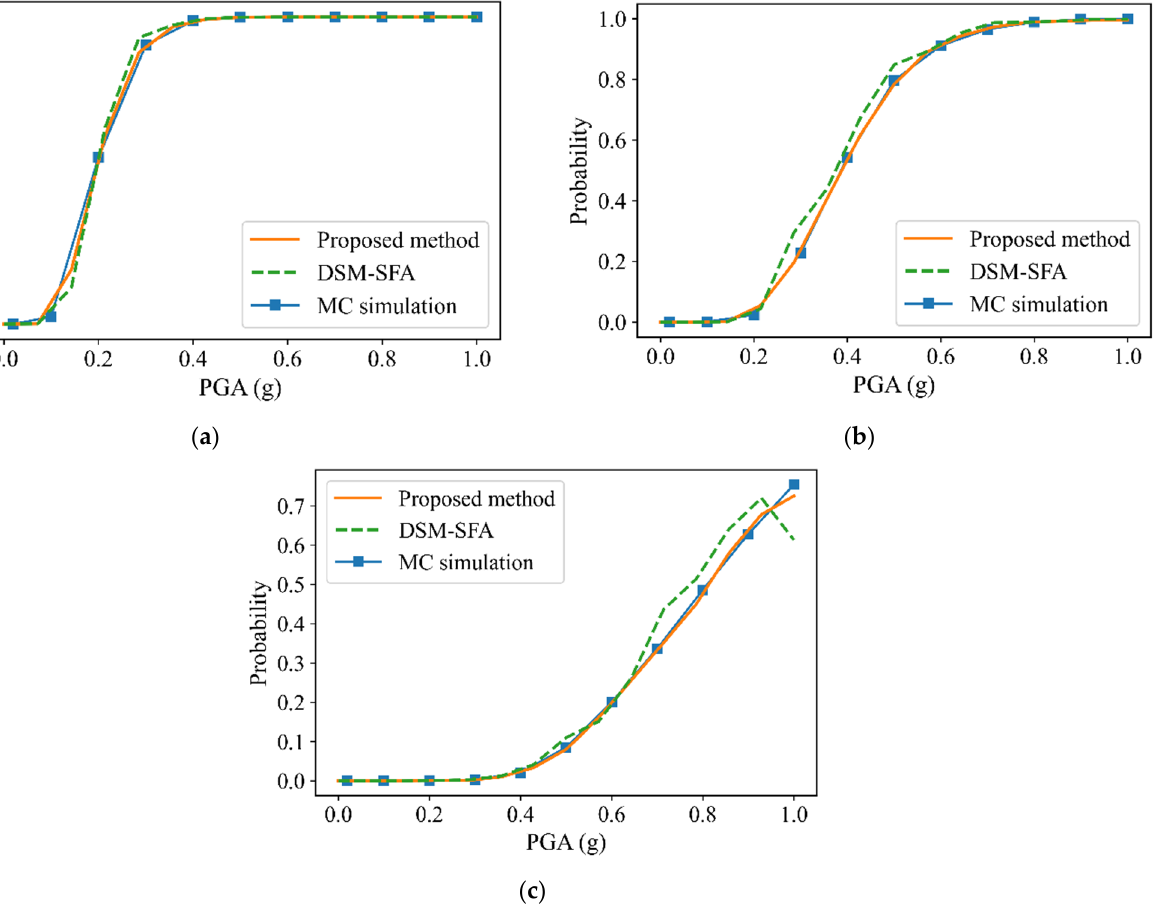
Figure 7. Fragility curves obtained using different approaches. ( a ) Immediate occupancy. ( b ) Life safety. ( c ) Collapse